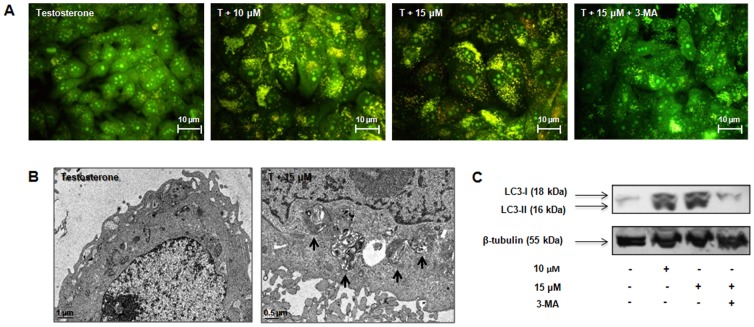
Exemestane and autophagy.(A) Effects of exemestane in the formation of AVOs analysed by fluorescence microscopy. MCF-7aro cells were treated with exemestane with or without 3-MA, during 6 days and stained with AO. The presence of AVOs was indicated by the yellow/orange/red fluorescence. (B) Ultrastructural features of cell death in MCF-7aro cells treated with exemestane for 6 days. The presence of autophagosomes (black arrows) was observed in the cytoplasm of treated cells. (C) Western Blot analysis of LC3-I/LC3-II. Cells were cultured with exemestane and with exemestane plus 3-MA for 3 days. β-tubulin was used as a loading control. Cells cultured with T were considered as control. Results are shown from a single representative of three independent experiments.